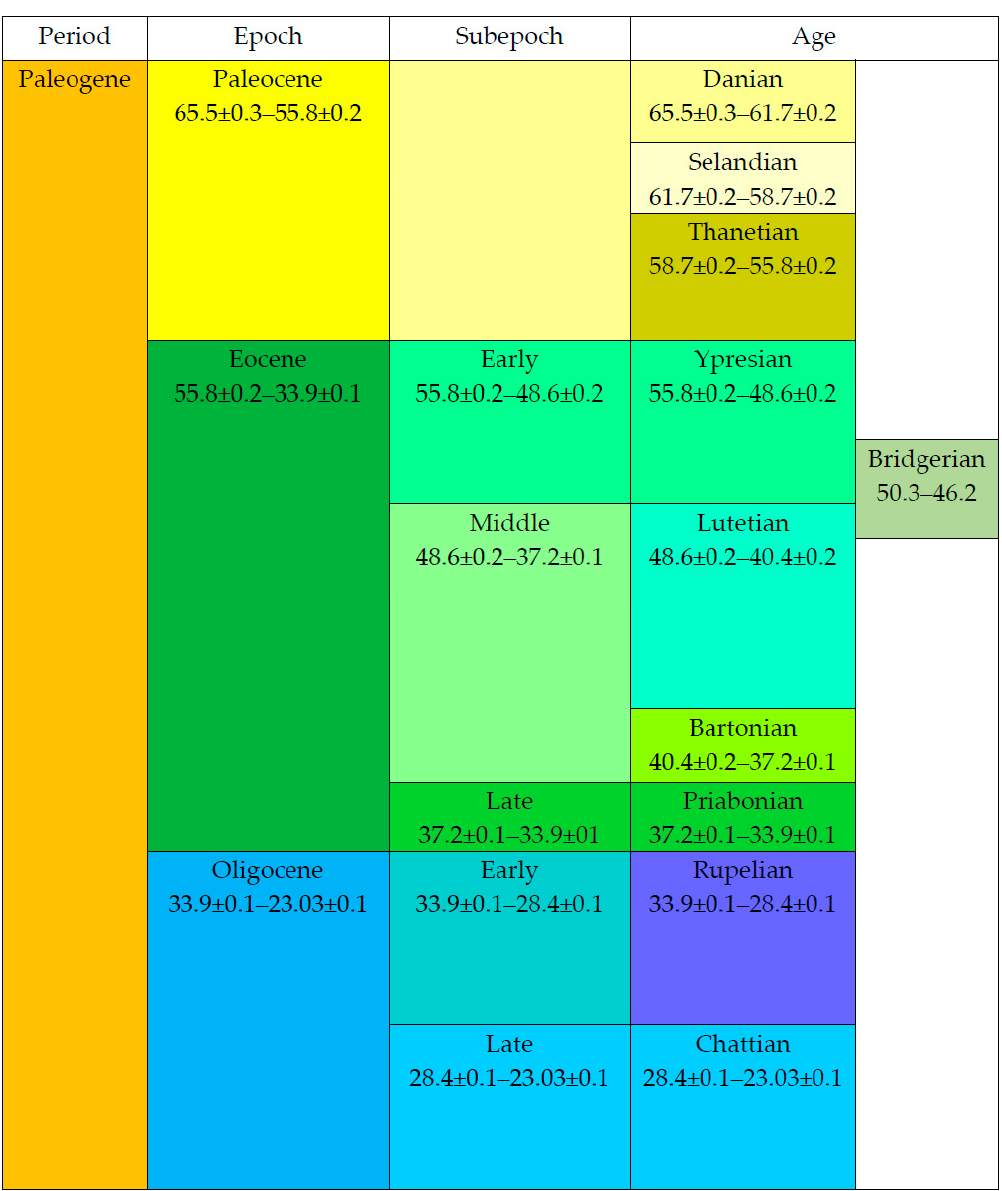
Figure 1. Geochronology of the Paleogene (Ma).